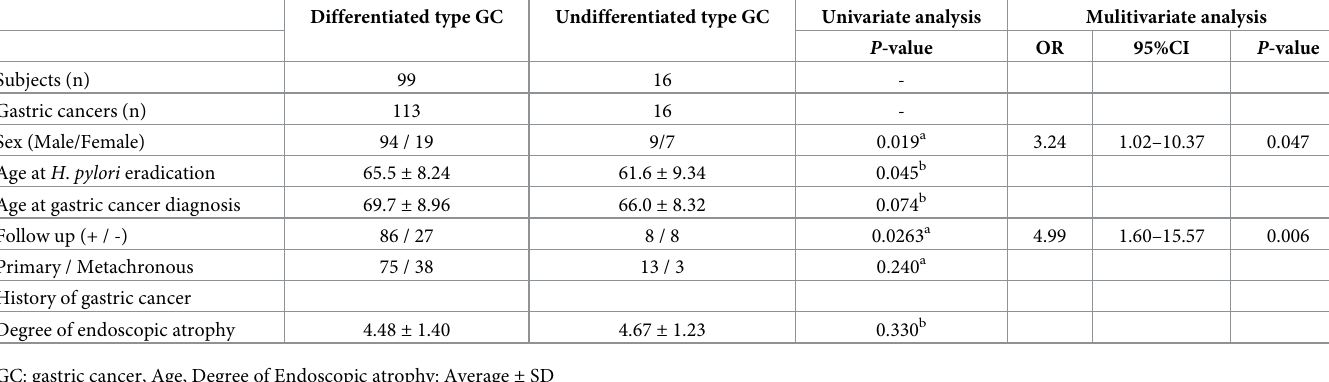
Table 3. Univariate and multivariate analyses of differentiated and undifferentiated gastric cancer